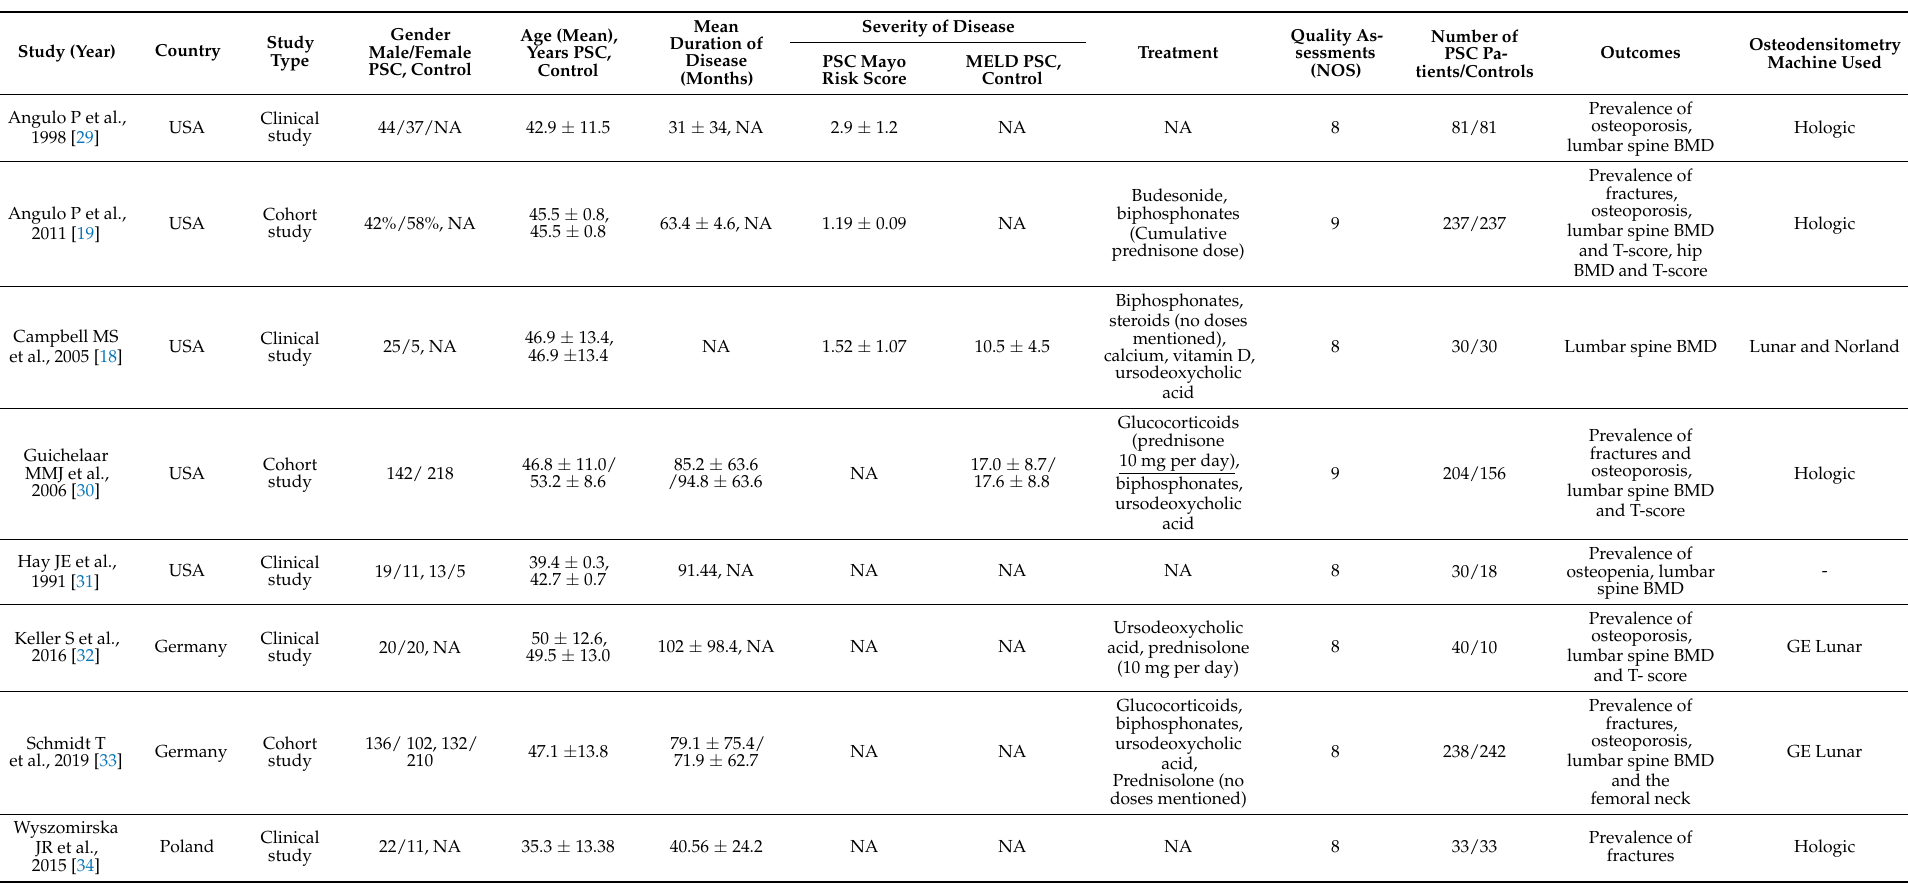
Table 1. Description of the characteristics of included